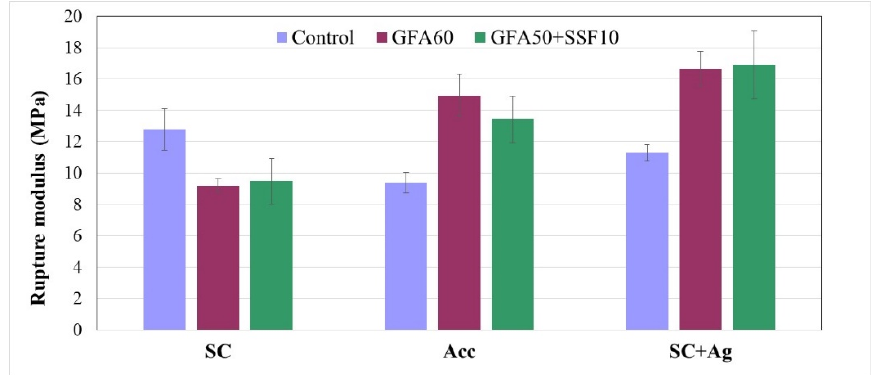
Figure 2. Modulus of rupture (bending strength) of the GRC composites. (SC, standard curing for 28 d at 20 °C; CS+Ag, 28 d SC plus aging for 28 d at 55 °C; Acc, short curing for 7 d at 20 °C plus Acc for 21 d at 55 °C).